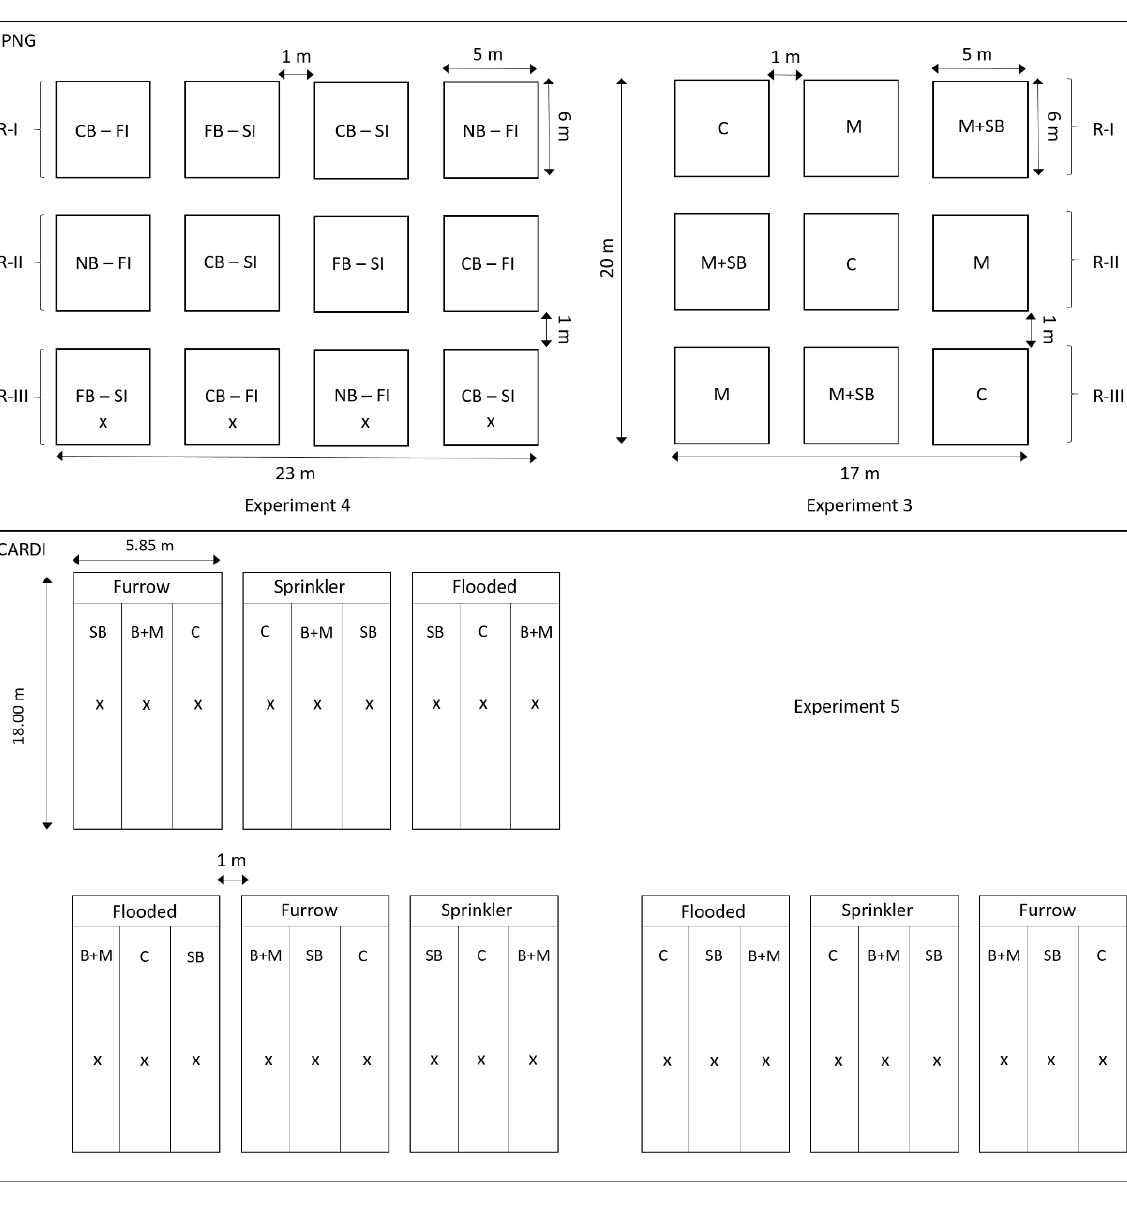
Figure 3. Experimental layout during the 2017/18 dry season at PNG (top) and CARDI (bottom). Location of the soil water tension sensors at both sites is indicated with the symbol “x”. C = control; M = manure; M + SB = manure plus rice straw buried; CB − FI = conventional bed furrow system with furrow irrigation; FB − SI = flat bed with sprinkler irrigation; NB − FI = narrow bed with furrow irrigation; CB − SI = conventional bed furrow system with sprinkler irrigation; SB = rice straw buried; B + M = biochar plus cow manure.